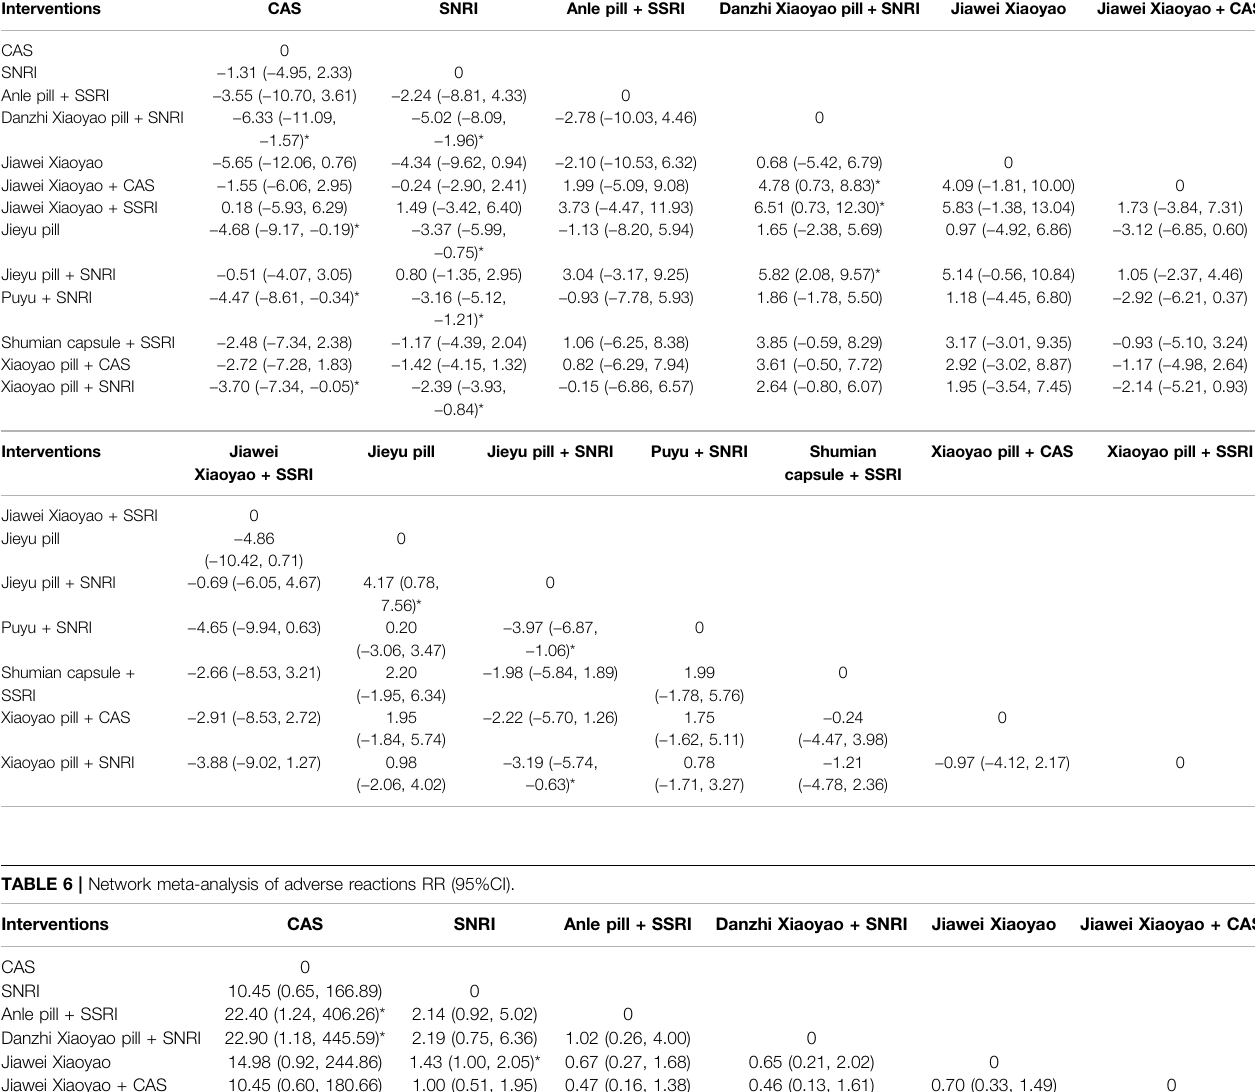
TABLE 5 | Network meta-analysis of HAMD WMD (95%CI).